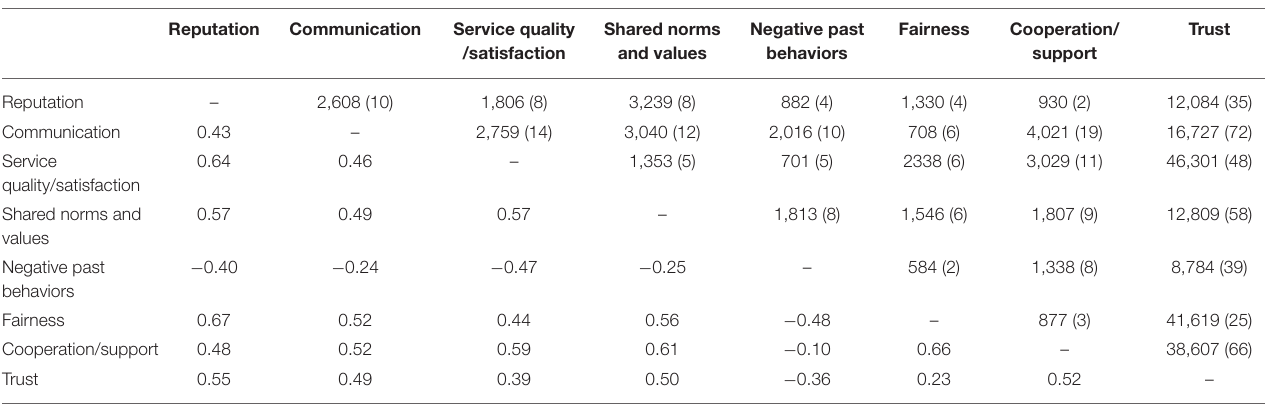
TABLE 3 | Intercorrelation matrix for antecedents and trust.